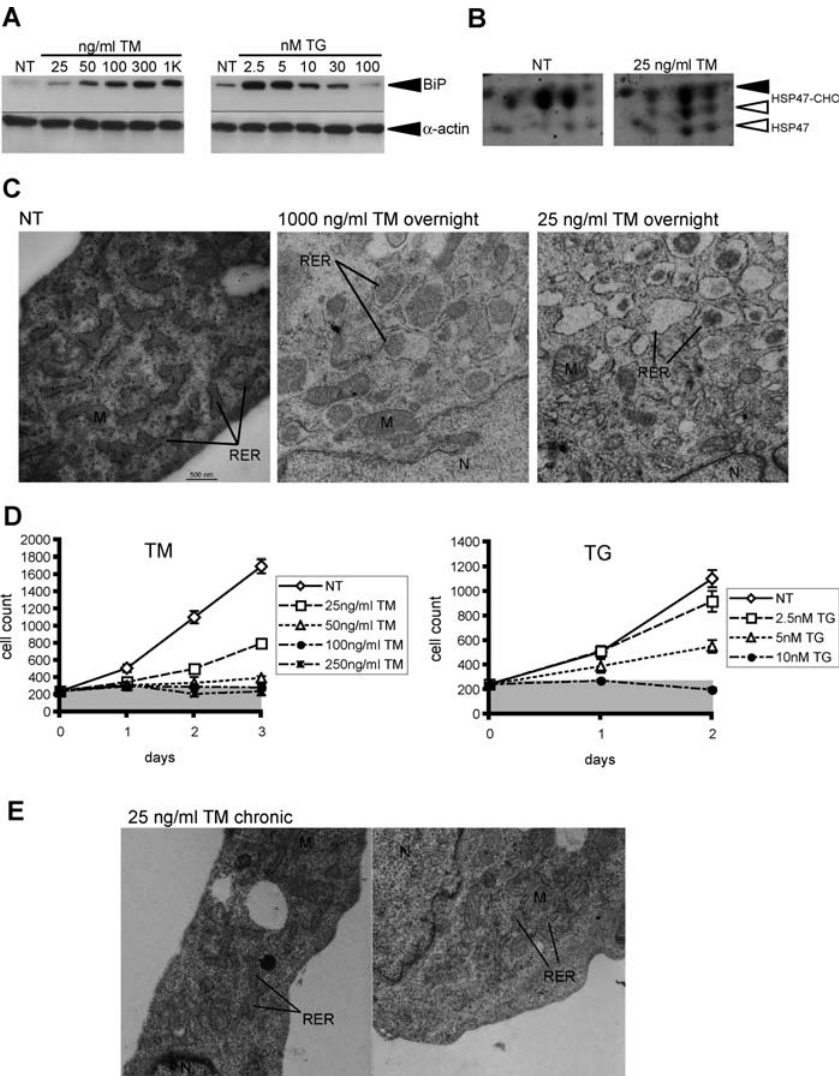
Figure 1. UPR Activation Can Permit Cell Survival and Proliferation (A) MEFs were cultured for 24 h in the presence of increasing concentrations of TM or TG. Cell lysates were then probed by immunoblot with antibodies specific for BiP, or a -actin as a loading control. (B) MEFs were cultured in the presence of 25-ng/ml TM or vehicle. The ER fraction was isolated from each by differential centrifugation, and was then separated by two-dimensional SDS-PAGE. The gels were stained for total protein with SYPRO Ruby. The series of spots corresponding to the